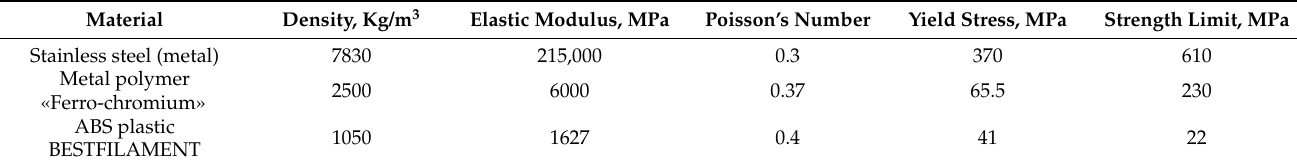
Table 3. Characteristics of the materials used in the calculations.